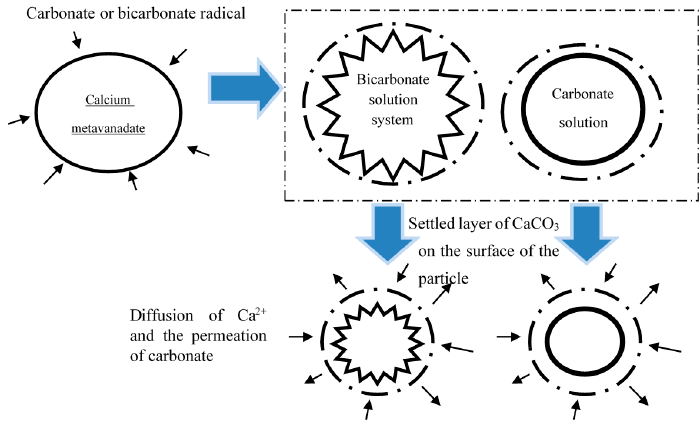
Figure 6. Reaction mechanism of the carbonate leaching reaction of calcium metavanadate.